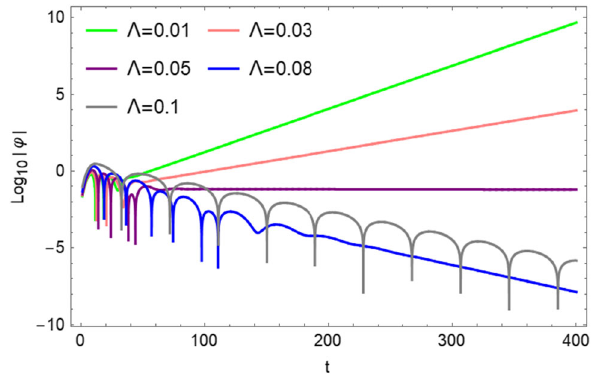
Fig. 5 The time evolution of perturbation mode with (cid:4) = 2. Here the GB coupling parameters is fixed as α = 10